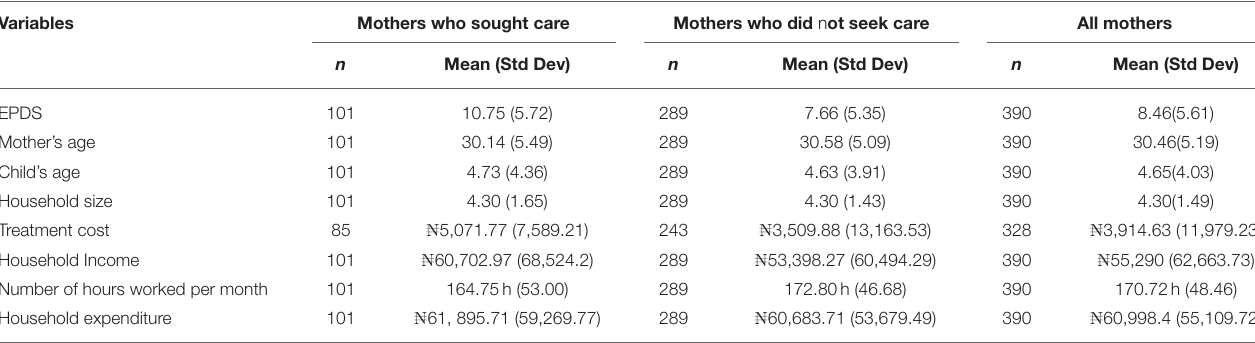
TABLE 1 | Descriptive characteristics of continuous